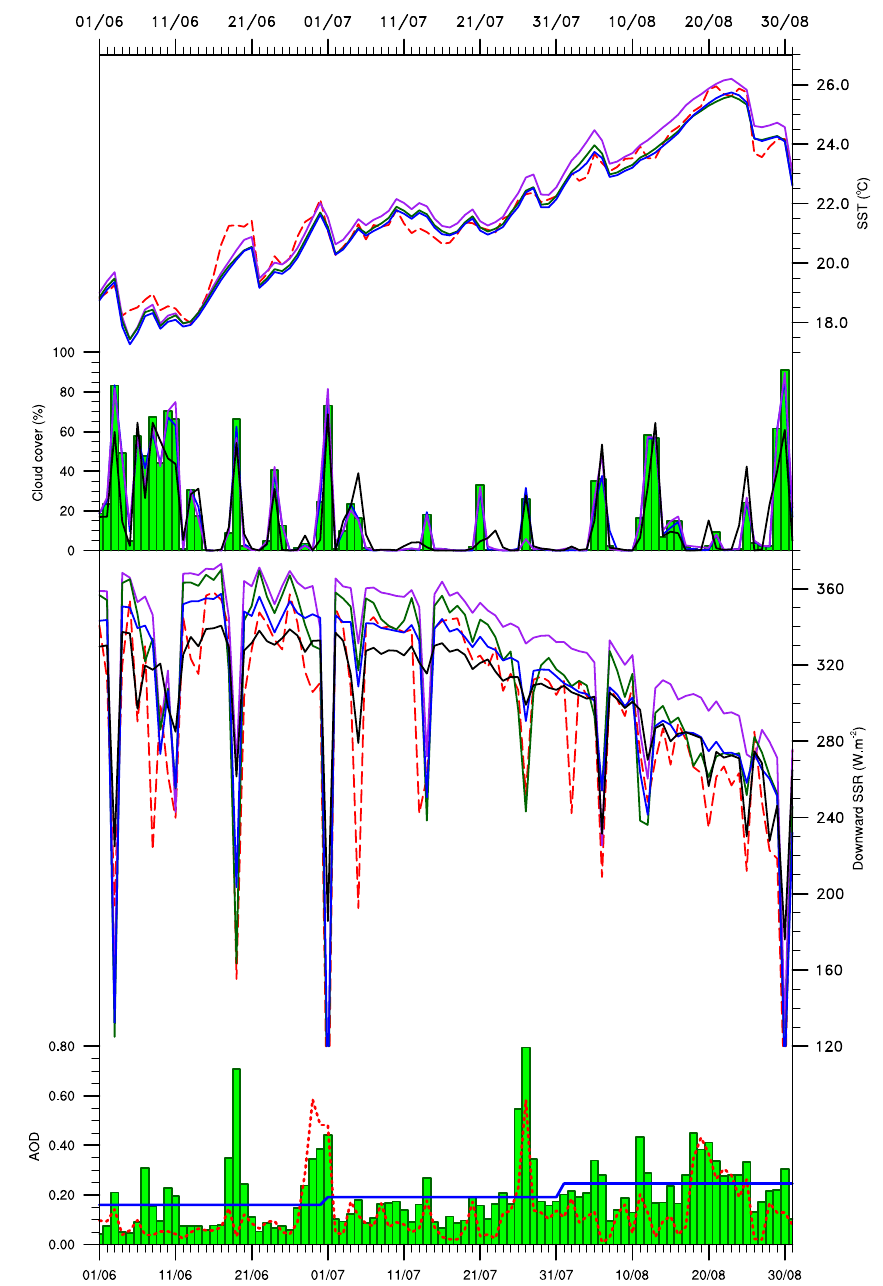
Figure 10. Same as Fig. 9 but for the buoy in the Gulf of Lions (LIO) and SST instead of 2m